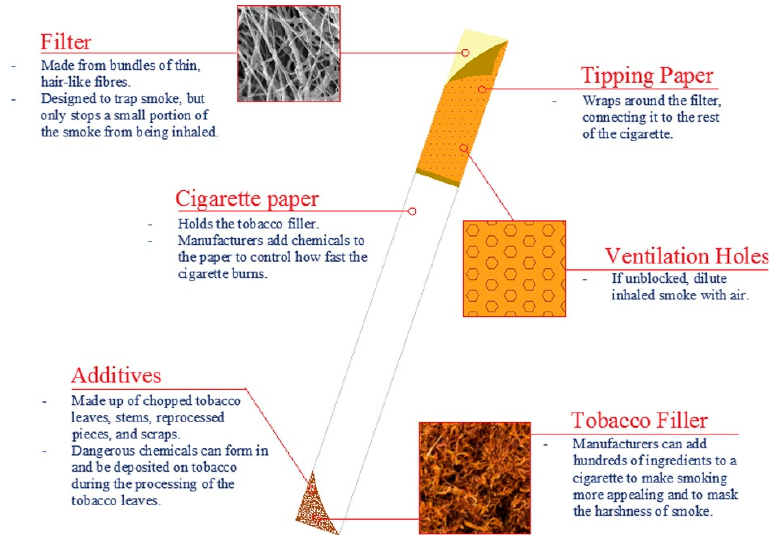
Figure 1. The compositional structure of a cigarette (from Kurmus and Mohajerani [1]).